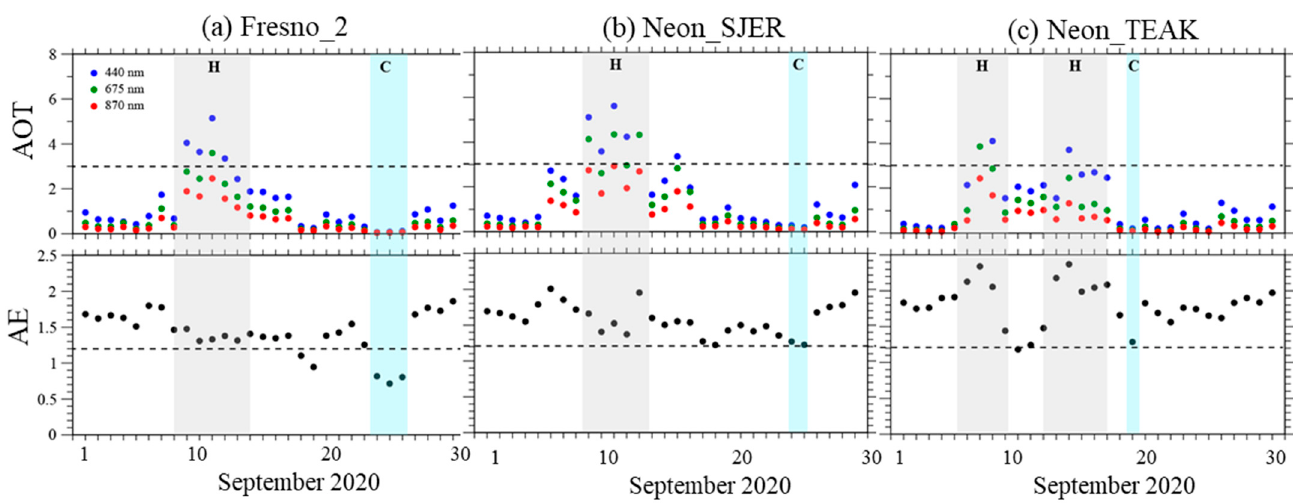
Figure 6. Daily averages for NASA/AERONET products within Area-S for September 2020. Area-S is comprised of three AERONET data collection sites: ( a ) Fresno_2; ( b ) NEON_SJER; and ( c ) NEON_TEAK. The charted gray vertical bands indicate a hazy atmosphere (H), and the blue vertical bands indicate a clear atmosphere (C). Aerosol optical thickness (AOT) is plotted on the upper graph; the dashed line denotes the highest average values (AOT = 3.0). Ångström Exponent (AE) values are plotted on the second graph; the dashed line denotes the smallest aerosol particles (AE = 1.2).